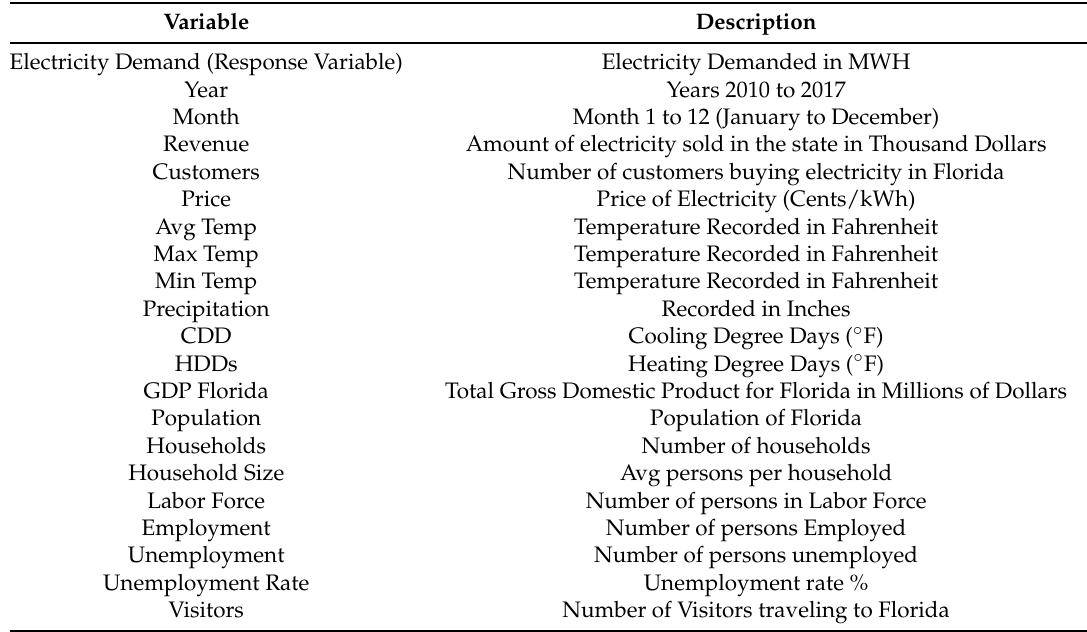
Table 1. Variables considered in the preparation of the proposed